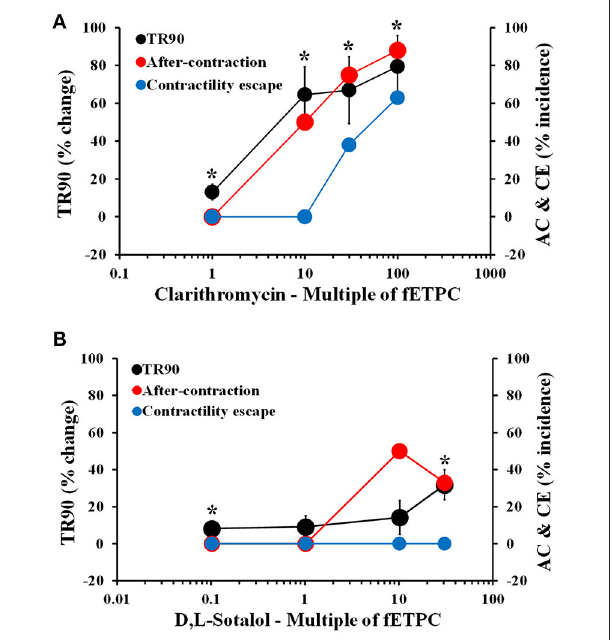
FIGURE 4 | Mean % change in TR90 and AC & CE % incidence when cardiomyocytes were treated with clarithromycin (A) and D,L-sotalol (B) . * P < 0.05 vs. values from